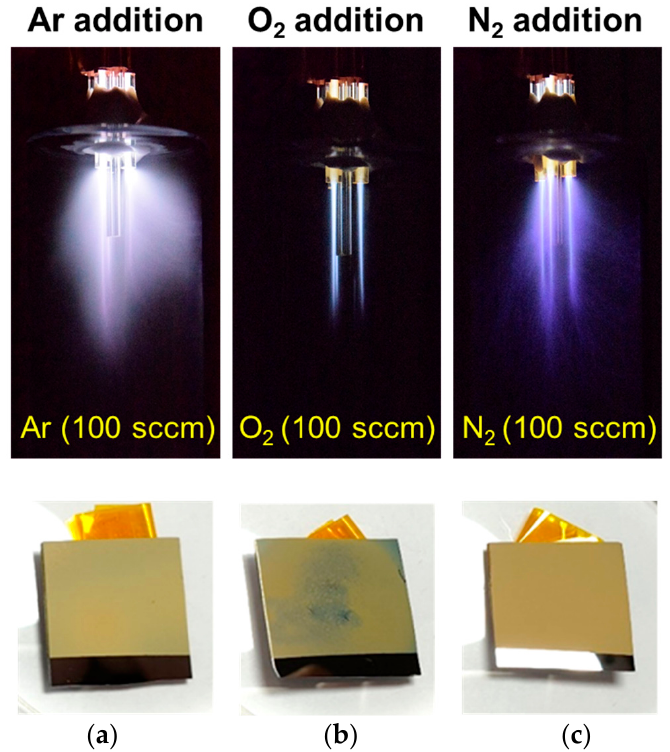
Figure 2. Images of glow plasma during plasma polymerization and PANI films deposited on Si substrates: image of Ar glow discharge during polymerization with the addition of ( a ) Ar, ( b ) O 2 , and ( c ) N 2 and images of the resulting PANI films. All additional gases were used at a flow rate of 100 sccm.